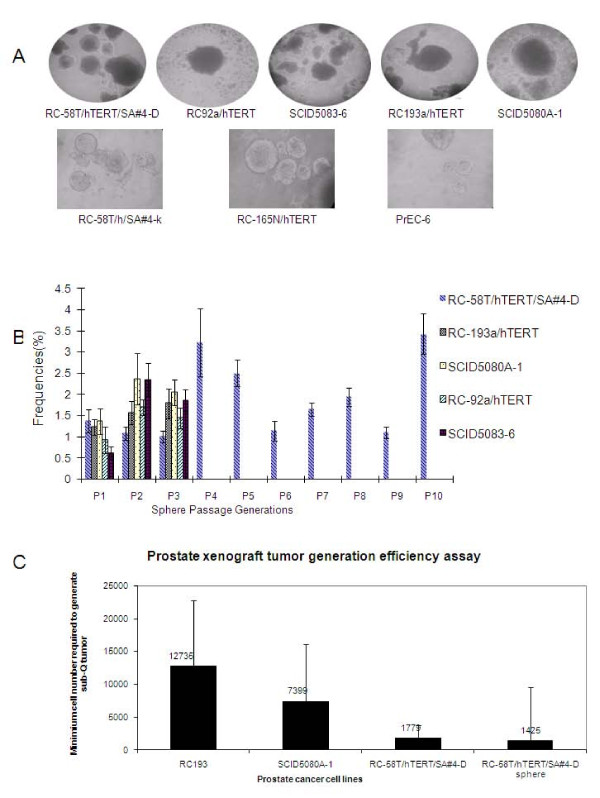
Tumorigenicity of hTERT-immortalized cells under non-adherent culture conditions and formation of xenograft tumors. A) hTERT-immortalized epithelial cells lines (RC-58T/hTERT/SA#4-D, RC-92a/hTERT, SCID5083-6, RC-193a/hTERT, and SCID5080A-1, RC-58T/h/SA#4-k, RC-165N/h, PrEC-6) from prostate cancer or non-cancer patients form spheroid structures (called here prostaspheres). The images were taken at 100 × magnification. B) Prostaspheres were serially passaged under non-adherent culture conditions. RC-58T/hTERT/SA#4-D was passaged 10 times without showing a decline in sphere forming capability. The passaging capacities of prostaspheres from RC-92a/hTERT, SCID5083-6, RC-193a/hTERT, and SCID5080A-1 were tested for three generations (n = 6; error bars indicate the standard deviation of sphere-forming efficiency for each type of cell line). C) Xenograft tumor generation with RC193a/hTERT, SCID5080A-1, RC-58T/hTERT/SA#4-D cells cultured as monolayers required large numbers of injected cells. The error bars indicate the lower and upper limits of the confidence interval based on the limiting dilution calculation.